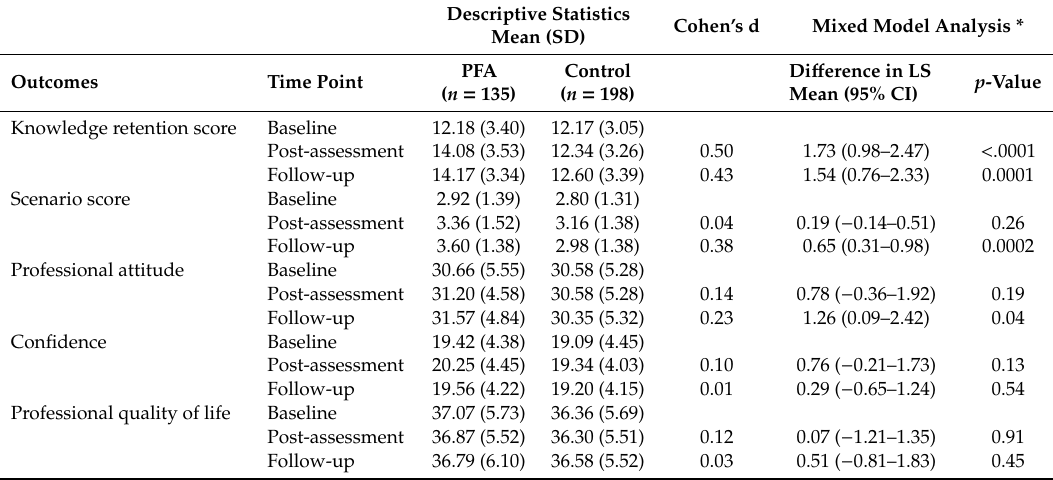
Table 2. Summary statistics and results from mixed model analysis of primary and secondary outcomes ( n =